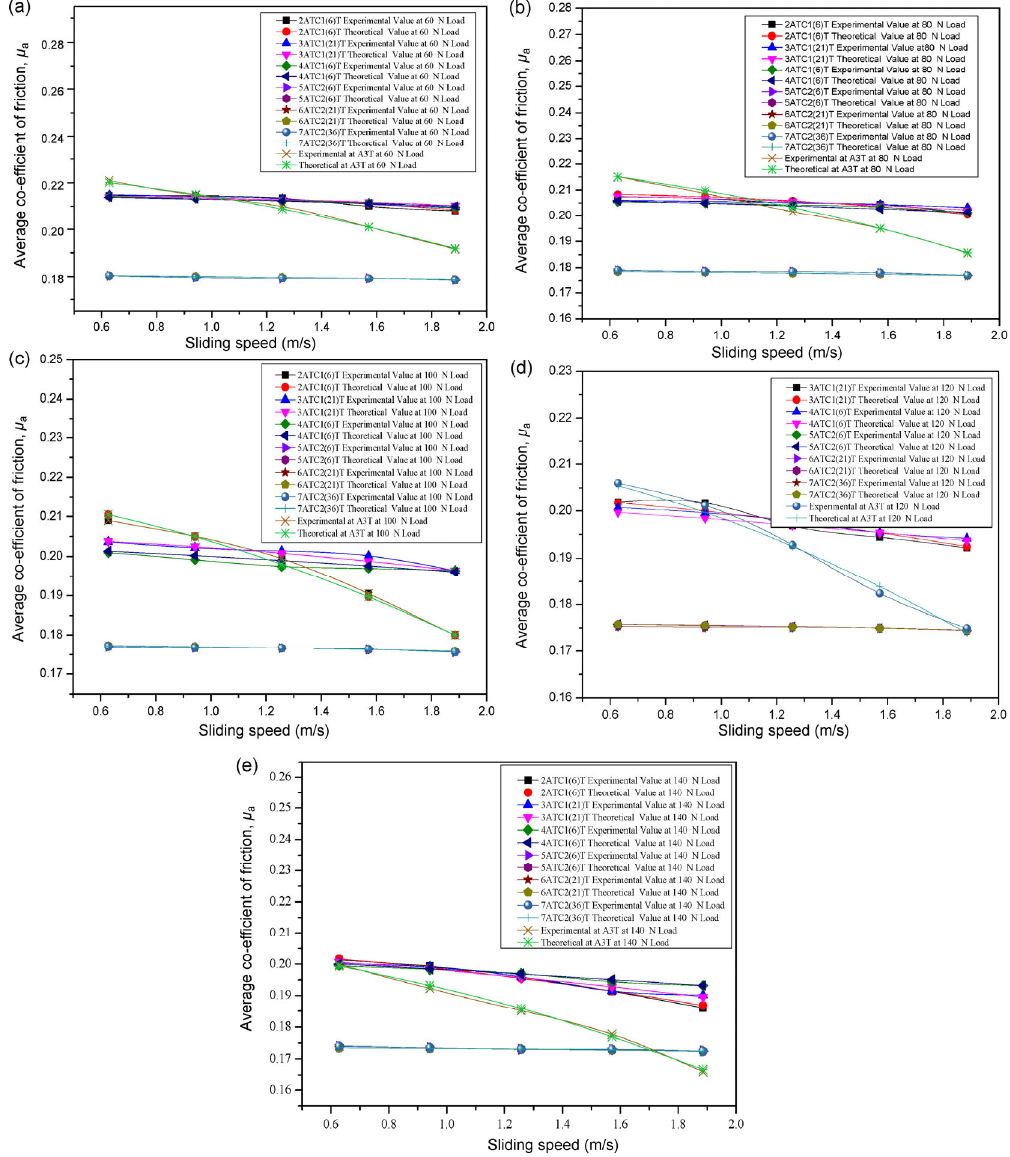
Fig. 14 Comparison of the theoretical and experimental results for the average coefficient of friction during the wear test at varying sliding speeds and loads: (a) 60 N, (b) 80 N, (c) 100 N, (d) 120 N, and (e) 140 N in the case of various treatments: A3T, ATC1(6)T, ATC1(21)T, ATC1(36)T, ATC2(6)T, ATC2(21)T, and